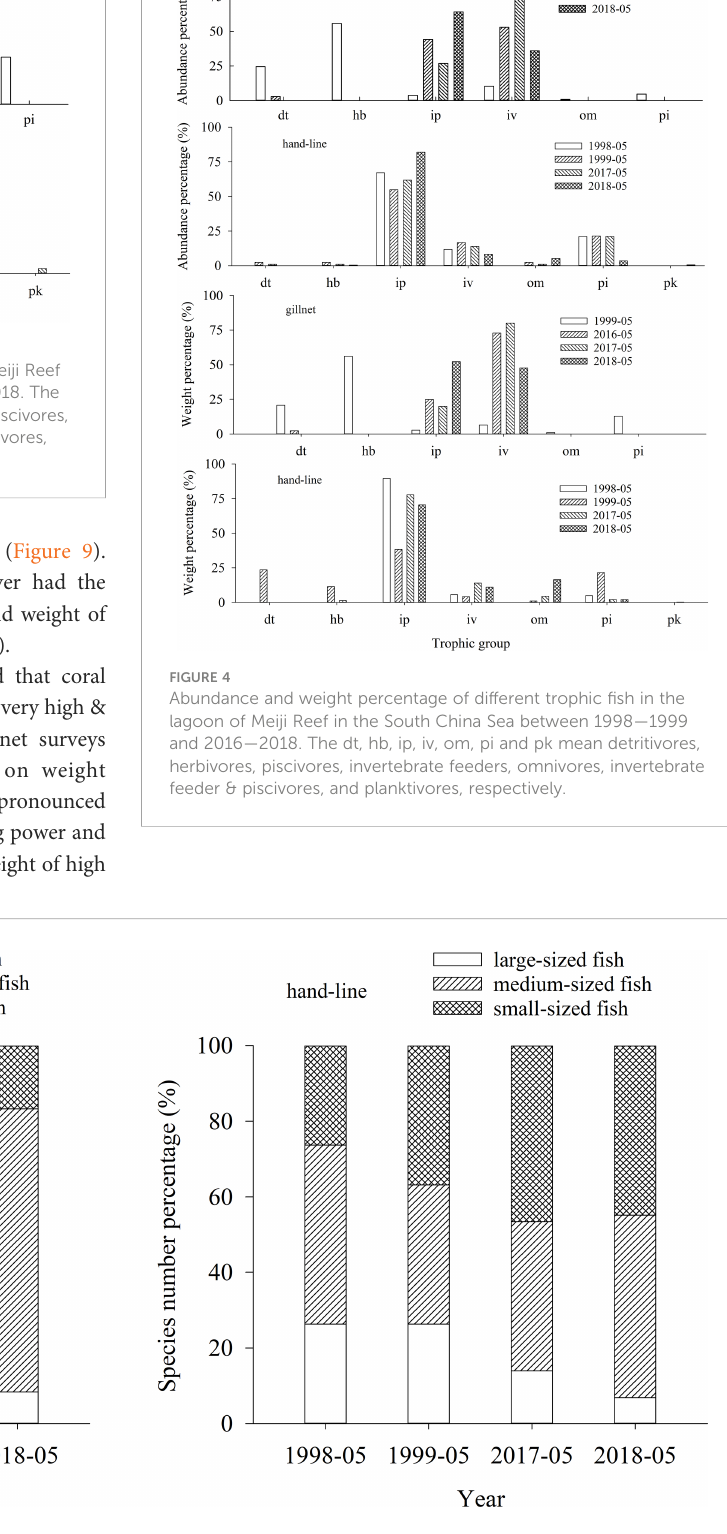
FIGURE 5 Distribution of fi sh size in the lagoon of Meiji Reef in the South China Sea between 1998 — 1999 and 2016 — 2018.